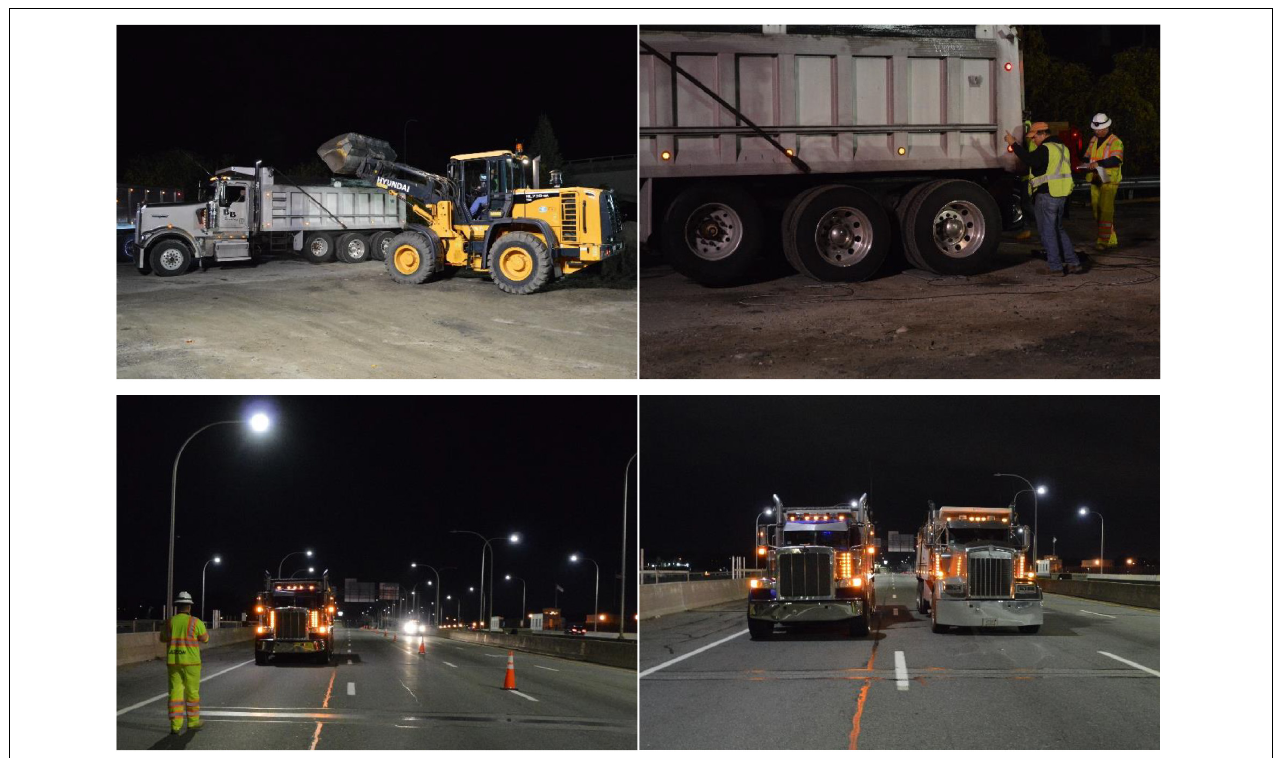
FIGURE 9 | Photos of loading and weighing test trucks and operating test